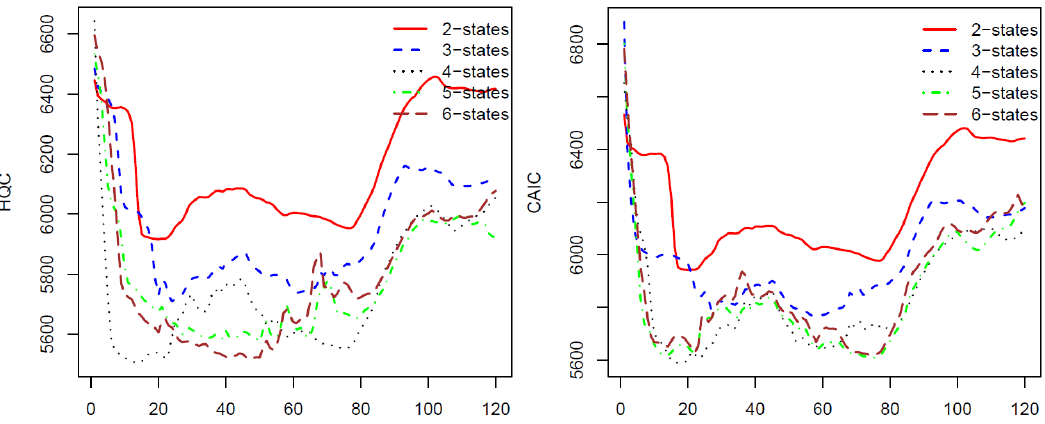
Figure 2. HQC ( left ) and CAIC ( right ) for 120 HMM’s parameter calibrations using S&P 500 monthly